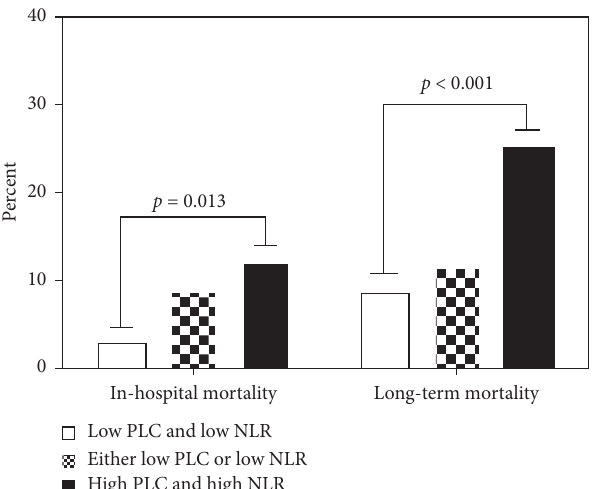
Figure 2: Clinical outcomes in 3 groups between in-hospital and long-term follow-up. Patients in the high PLC and high NLR group had significantly higher rates of all-cause mortality. Abbreviations: PLC, platelet count; NLR, neutrophil-to-lymphocyte ratio. 100